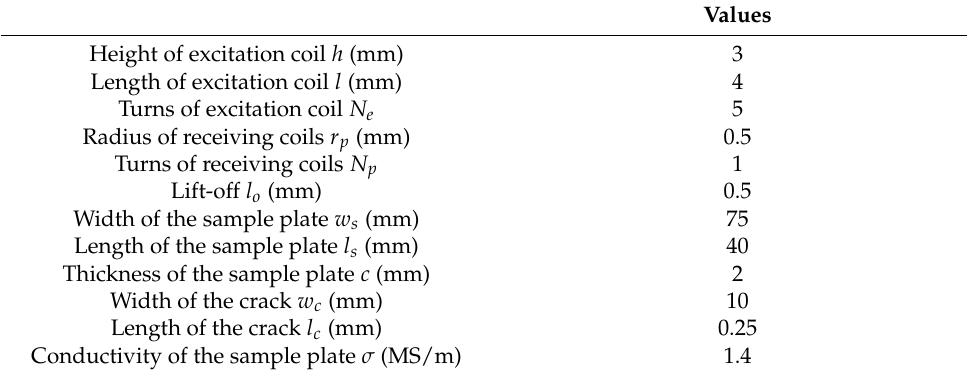
Figure 1. Simulation models ( a ) the rotation direction of the sensor probe ( b ) the stainless-steel plate with/without the crack. Table 1. Model parameters.